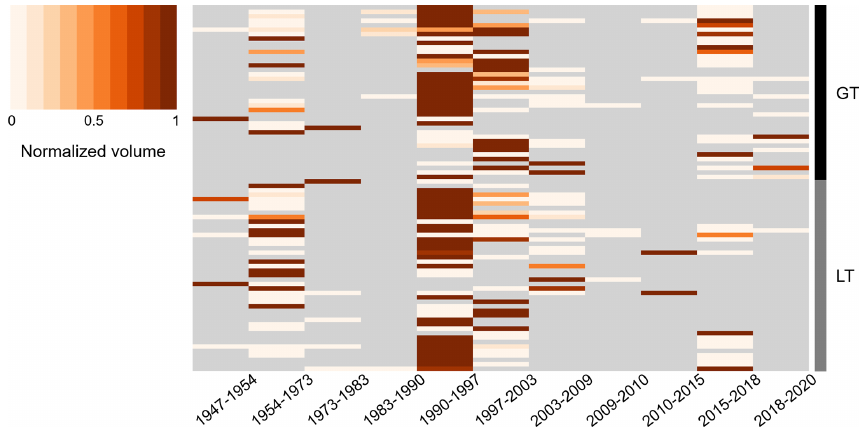
Figure 12. Heatmap of the 82 different starting zones in GT and LT, which were triggered at least twice between 1947 and 2020. The normalized magnitudes of every starting zone are shown by the colouring scheme. For more details refer to the text.